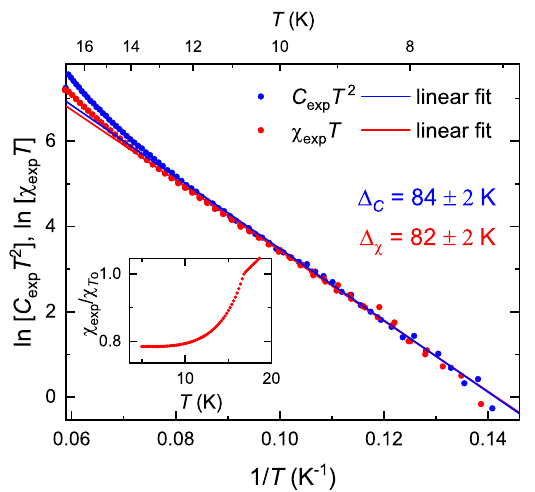
Fig. 4 Arrhenius plot. ln ½ C exp T 2 (cid:6) (blue circles) versus 1/ T at B = 0, which we fi t to ln ½ C Δ T 2 (cid:6) (blue line) where C Δ is given by Eq. (3). We T (cid:6) (red circles, shifted to bring it into compare this against ln ½ χ exp alignment with the speci fi c heat) fi t to χ Δ (red line) given by Eq. (4), is the measured susceptibility (shown in the inset). Solid where χ exp lines fi ts are used to provide gap estimates Δ C and Δ χ , obtained from the speci fi c heat and susceptibility,